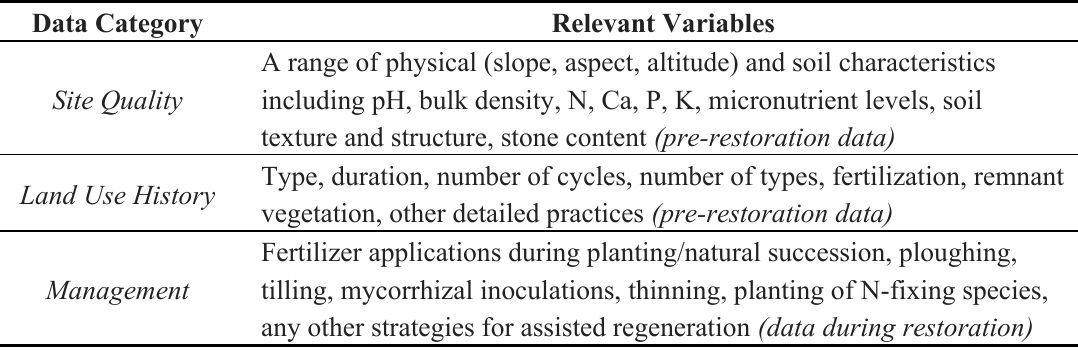
Table 2. Data necessary to assess a site’s carbon sequestration potential. These data should ideally be collected in all sequestration studies and at sites prior to the implementation of any carbon land management